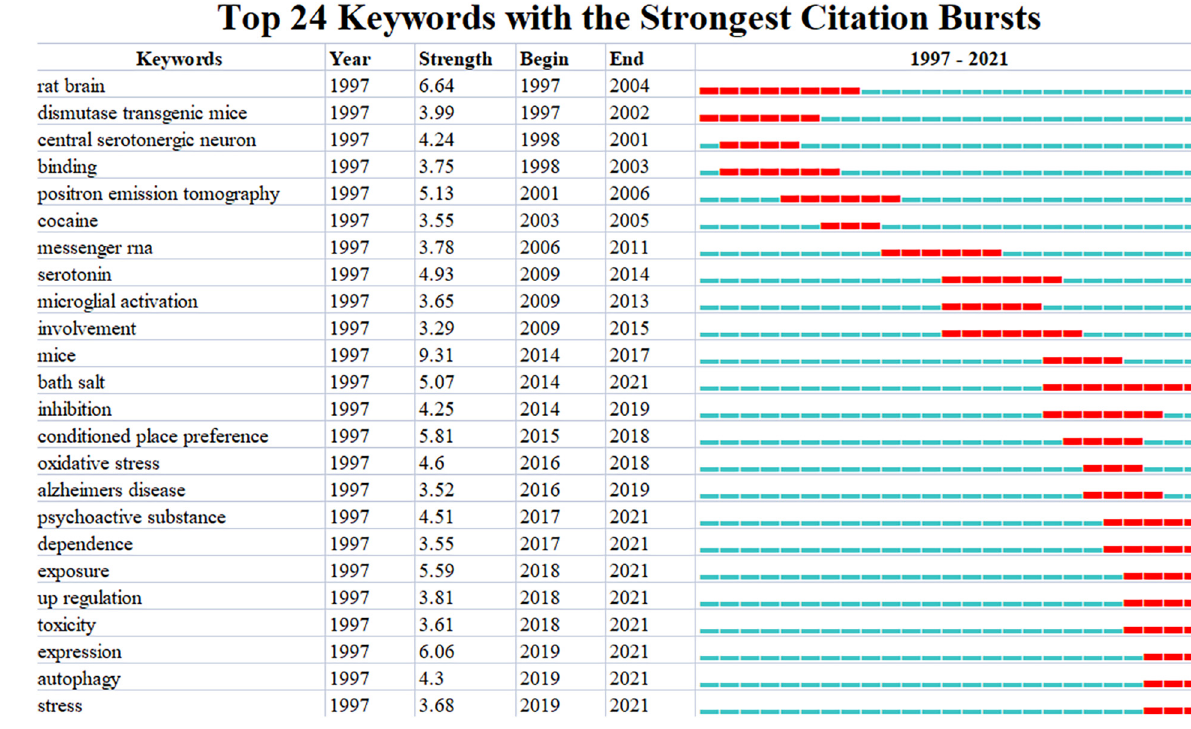
FIGURE 6 | Top 24 keywords with the strongest citation bursts. Each blue or red short line represents a year, and a red line stands for a burst detected